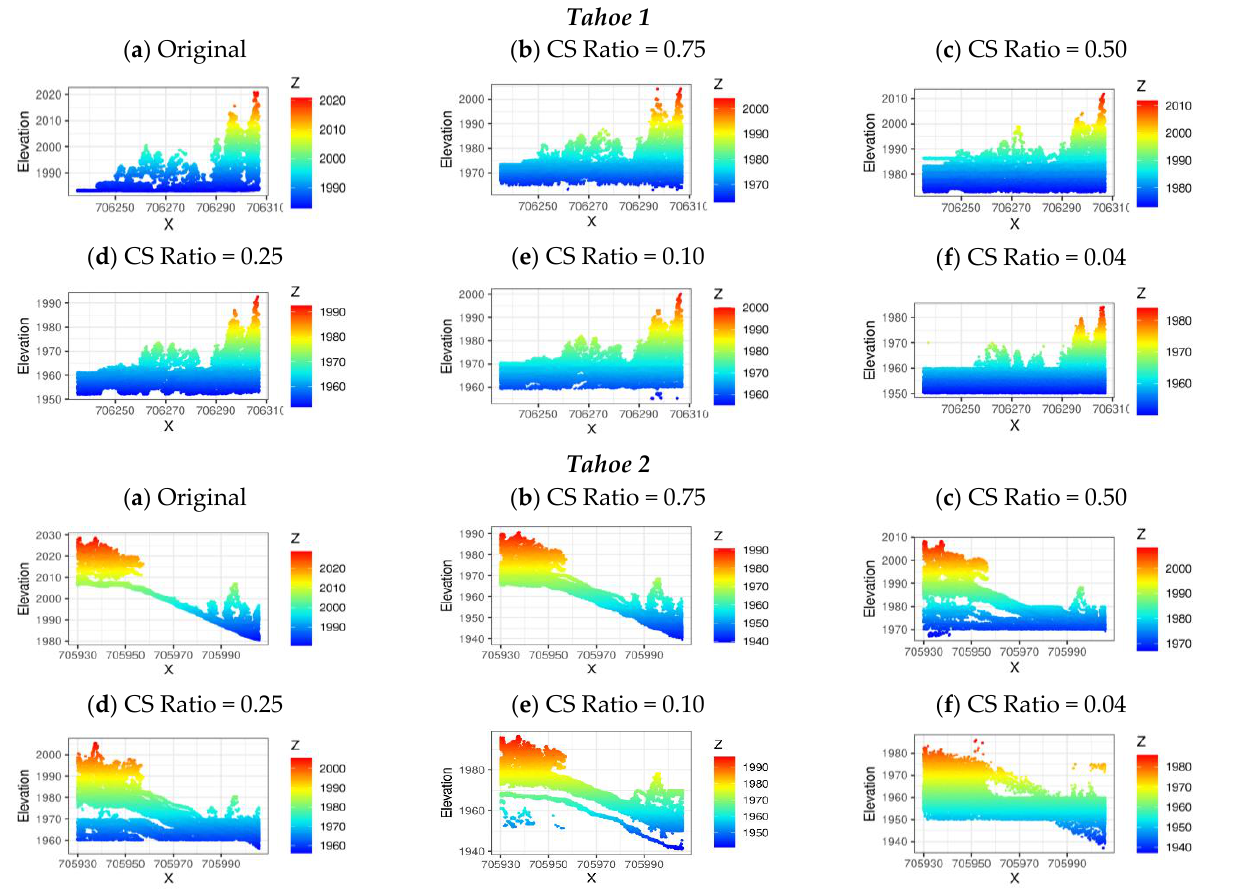
Tahoe 1 Tahoe 1